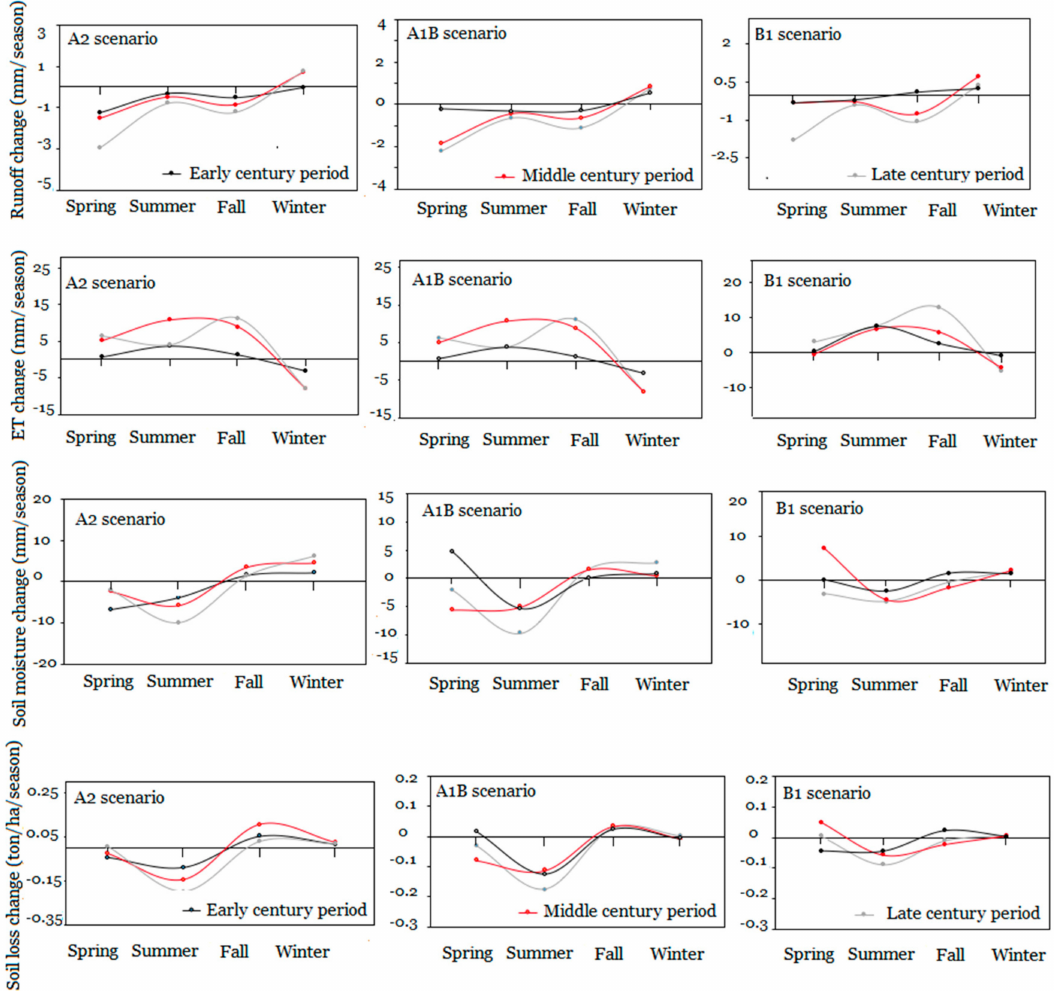
Figure 6. Seasonal changes of soil moisture, ET, runoff, and soil loss changes over three future periods under three SRES